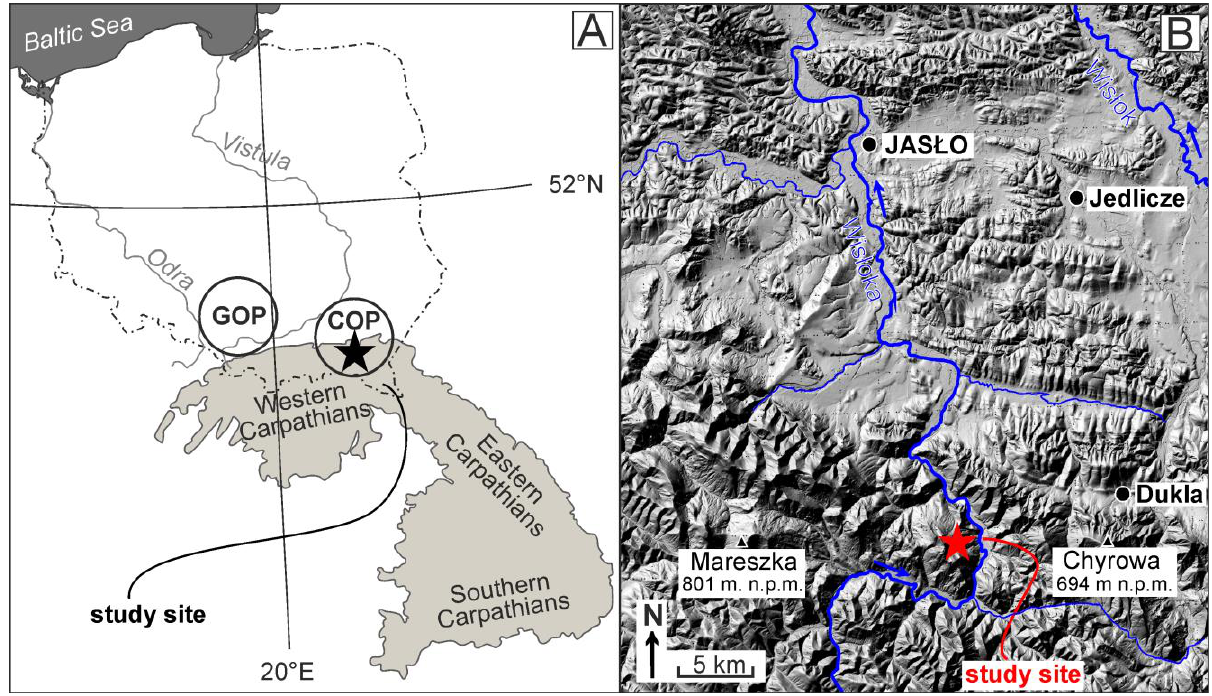
Fig. 1. Situation of the study site in Poland and within the Carpathians in relation to the main sources of pollution – the Upper Silesian Industrial Region (abbreviated GOP) and the Central Industrial Region (abbreviated COP) (A) and in the Beskid Niski Mountains